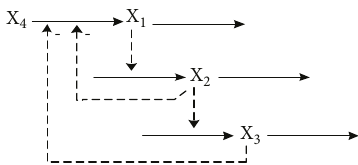
Figure 1: Cascade pathways